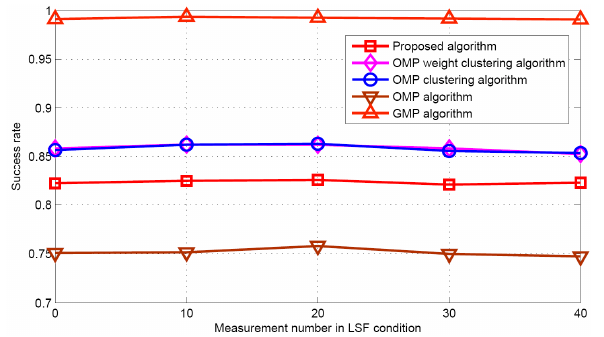
Figure 17. Success rate comparison.